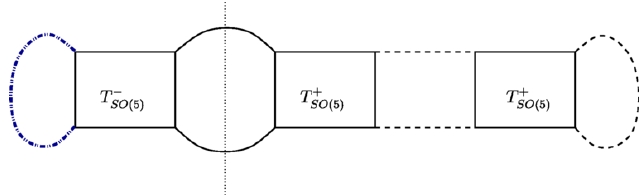
Figure 9 . Construction of a genus four theory with one unit of u (1) t (cid:13)ux with G max = so (5) u (1). The (cid:6) subscript denotes the sign of the theory. The squares are four punctured spheres of the G max = so (5) u (1) theories. Solid lines are connecting punctures of opposite sign and dashed lines punctures of same sign. Di(cid:11)erent dashed lines connect pairs of maximal punctures of di(cid:11)erent colors and/ or